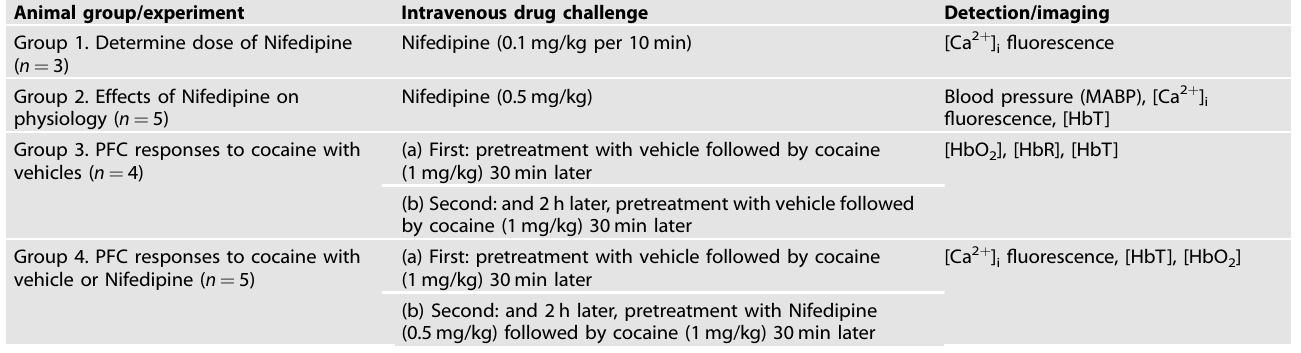
Table 1. Animal groups and experimental